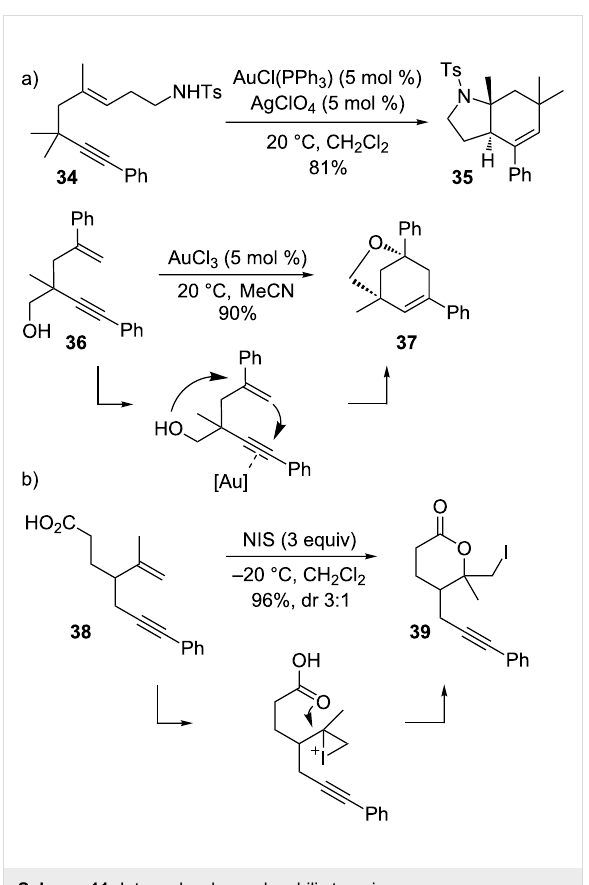
Scheme 11: Intramolecular nucleophilic